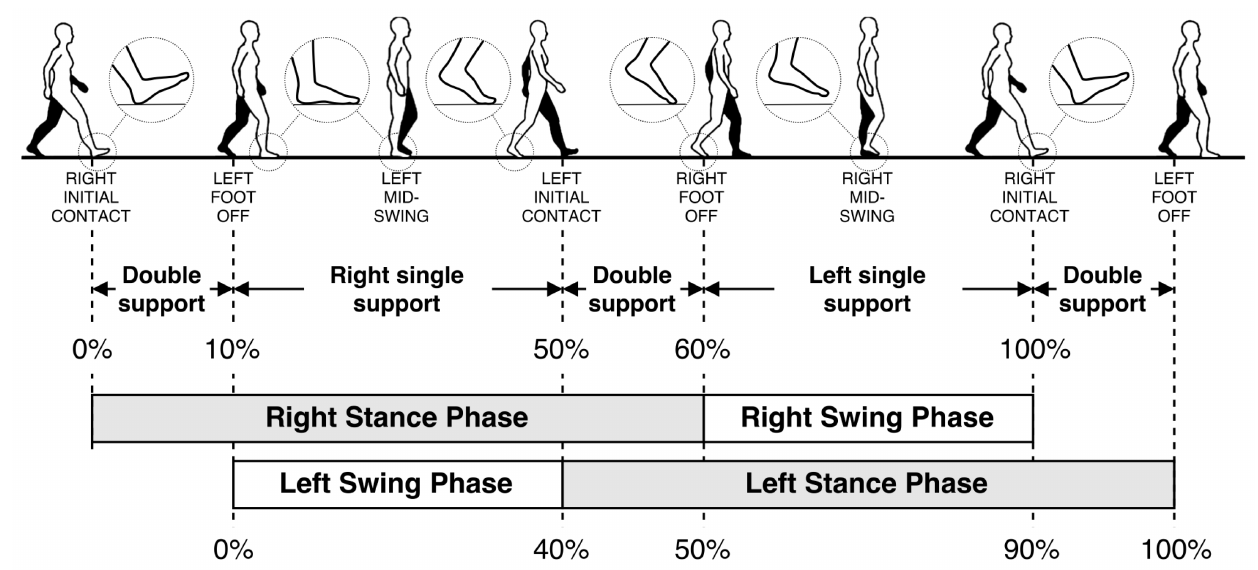
Figure 3. Graphical representation of the gait phases (image from